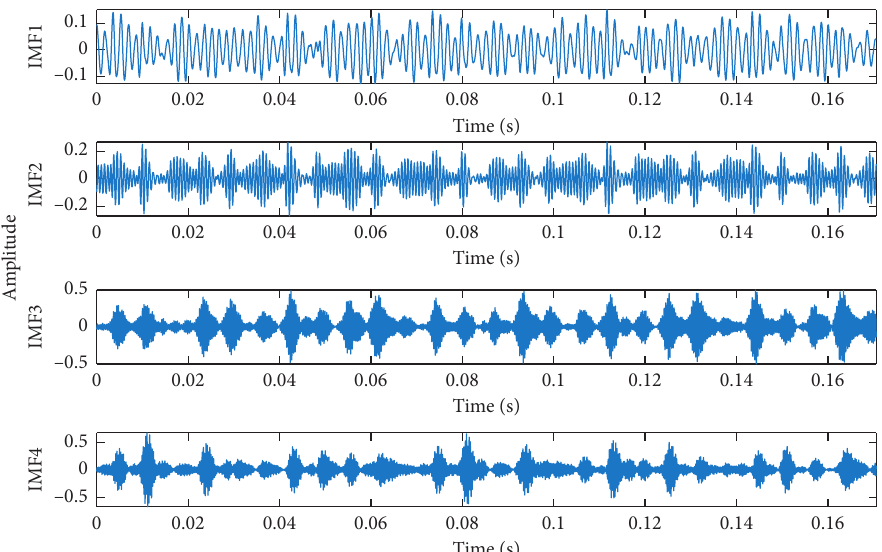
Figure 6: The time-domain diagram after inner ring fault signal